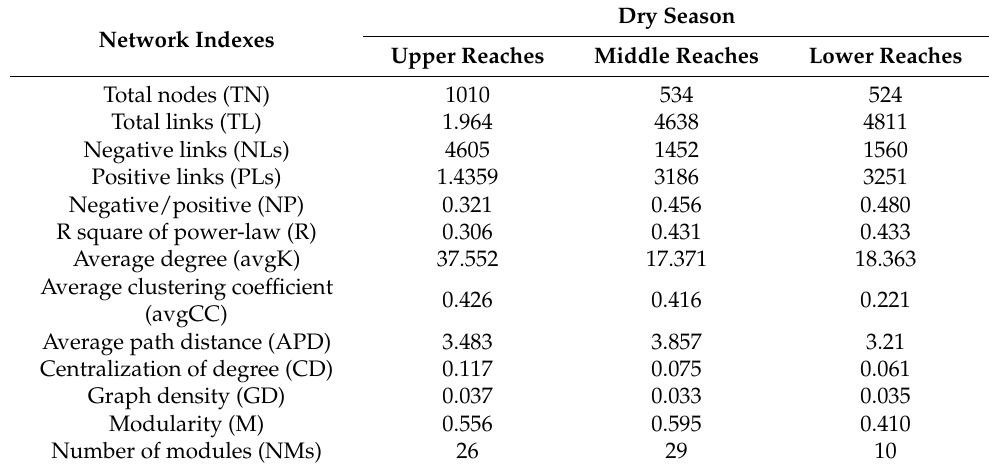
Table 2. The topological properties of the bacterioplankton molecular ecological networks during the dry